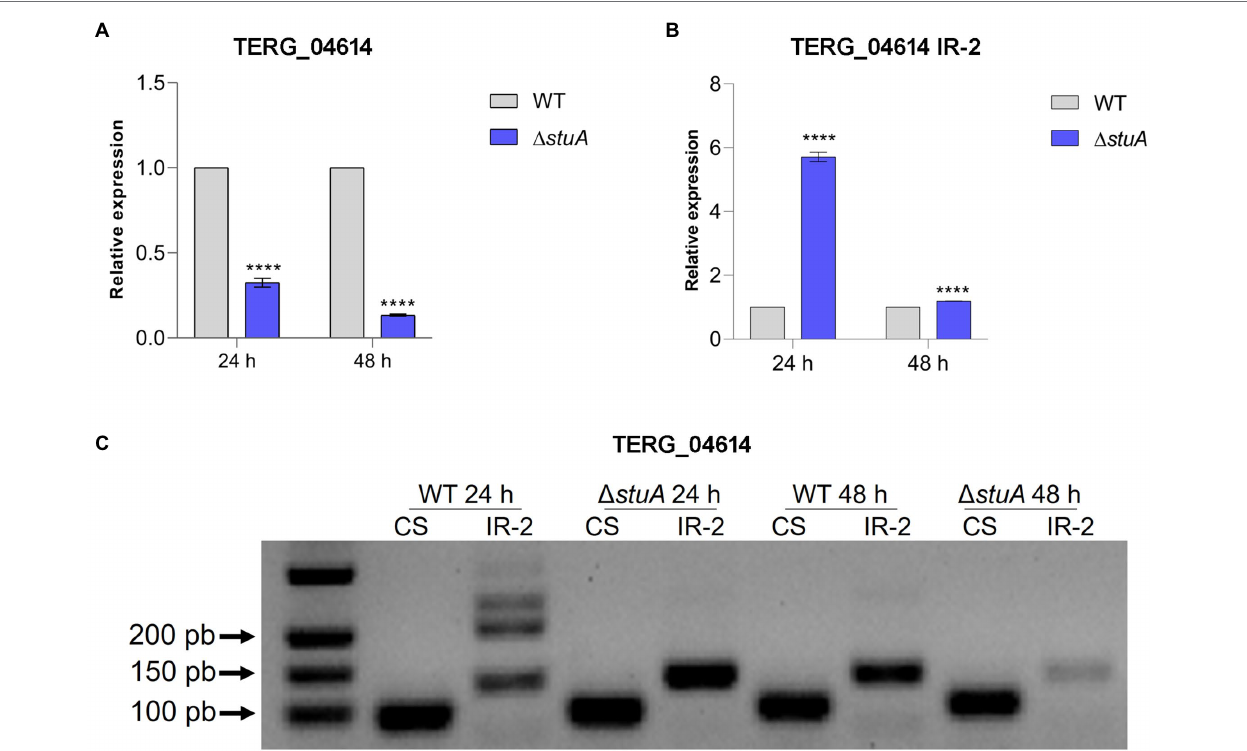
FIGURE 3 | (A) Relative expression of the CS isoform of TERG_04614 with WT strain transcript levels as the reference. (B) Relative quantification of the IR isoforms of TERG_04614 considering CS isoform transcript levels of each strain as references. (C) CS and IR (intron 2 retention-IR-2) isoforms in agarose gel after conventional amplification using cDNA of each strain as template. Statistical analyses for transcript quantification experiments were carried out using unpaired t - tests, and statistical significance was determined by the Holm-Sidak method considering **** p <